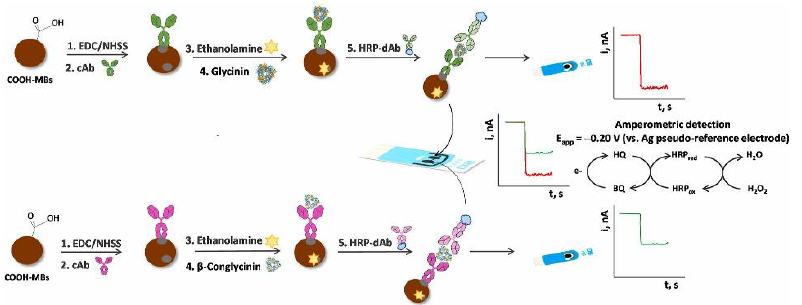
Figure 4. Schematic representation of the bioplatform assembly and the immunosensing mecha- nism involving the amperometric determination of β -conglycinin and glycinin at SPCE. Reprinted from [106].